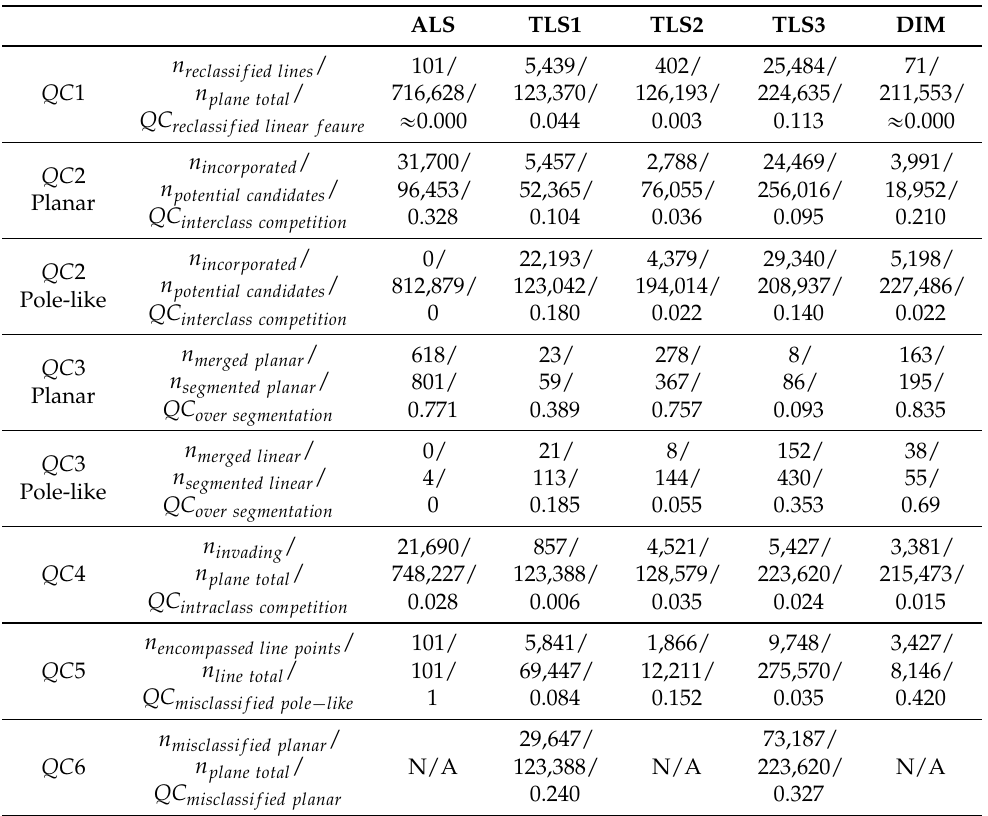
Figure 11. Perspective views of the segmented point clouds after the quality control procedure for the ALS–planar ( a ); DIM–planar ( b ); TLS1–planar ( c ); TLS1–pole-like ( d ); TLS2–planar ( e ); TLS3–planar ( f ); and TLS3–pole-like ( g ) datasets—different segments are shown in different colors. Table 3. QC measures for the different